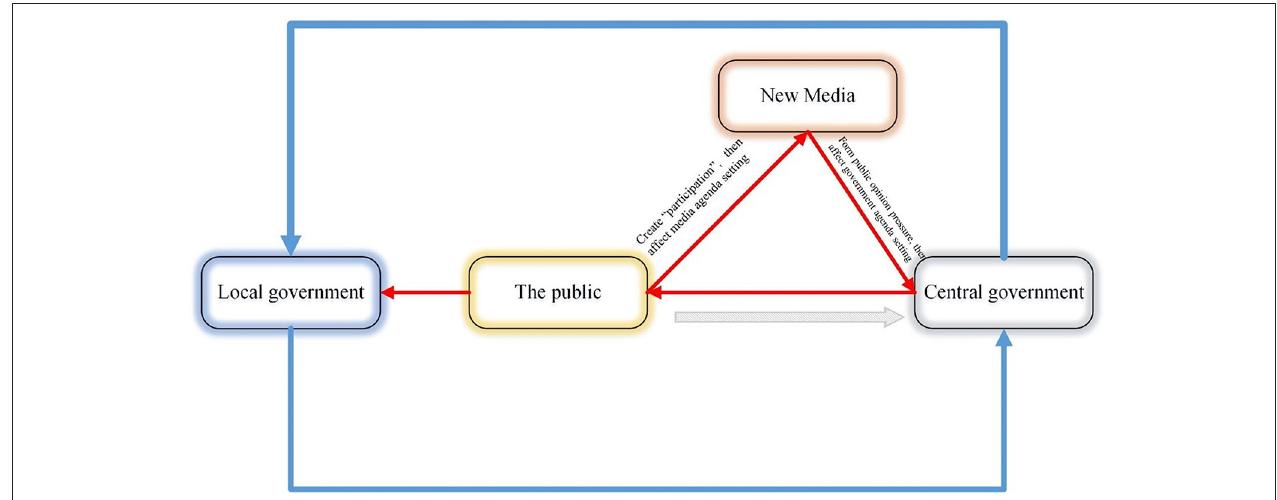
FIGURE 1 | The theoretical framework of public participation in central government